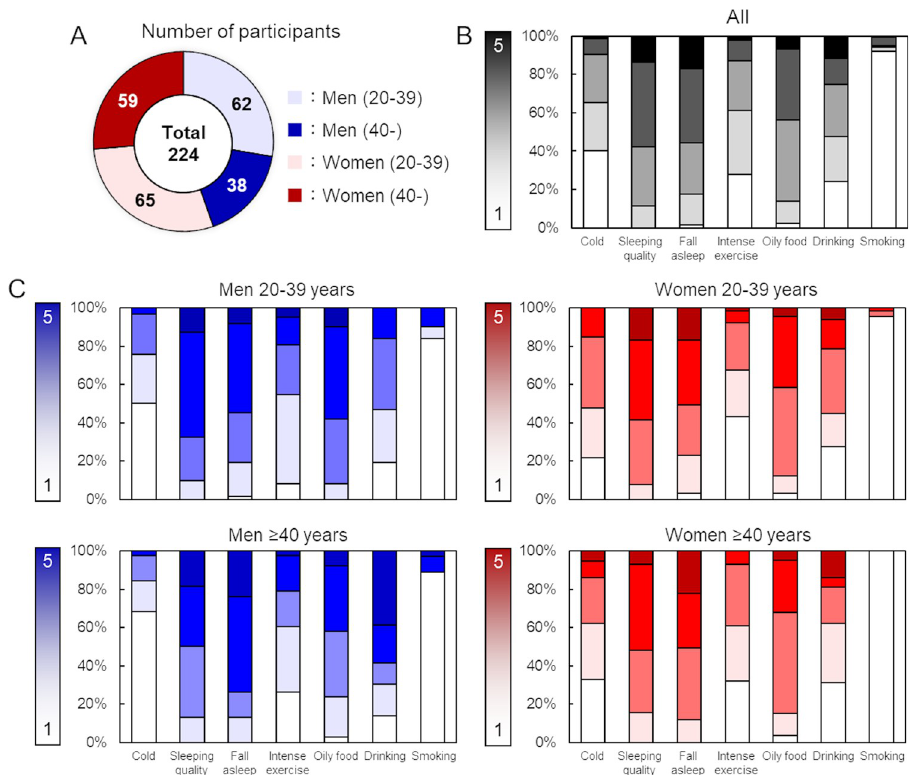
Fig 3. Characteristics of participants in the broad study. A: Distribution of sex and age in the broad study described in number of participants. B: Percentage of lifestyle habit scores in all participants. C: Percentage of lifestyle habit scores divided into men or women with aged 20–39 or � 40 years. White indicated low scores, and black or dark color meant higher scores with gradient.